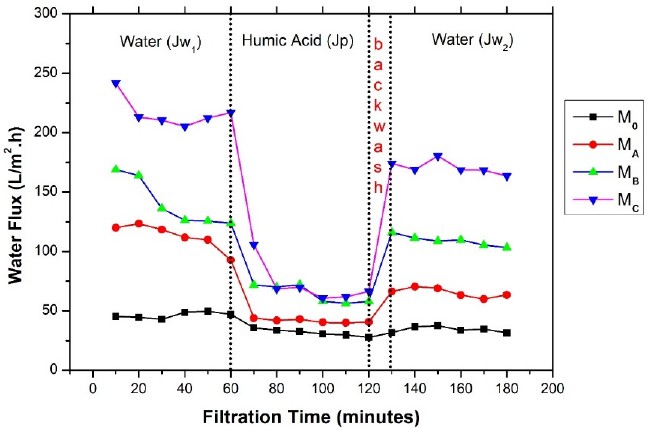
Figure 10. The profile of water flux decline and the recovery during filtration of DI water and HA